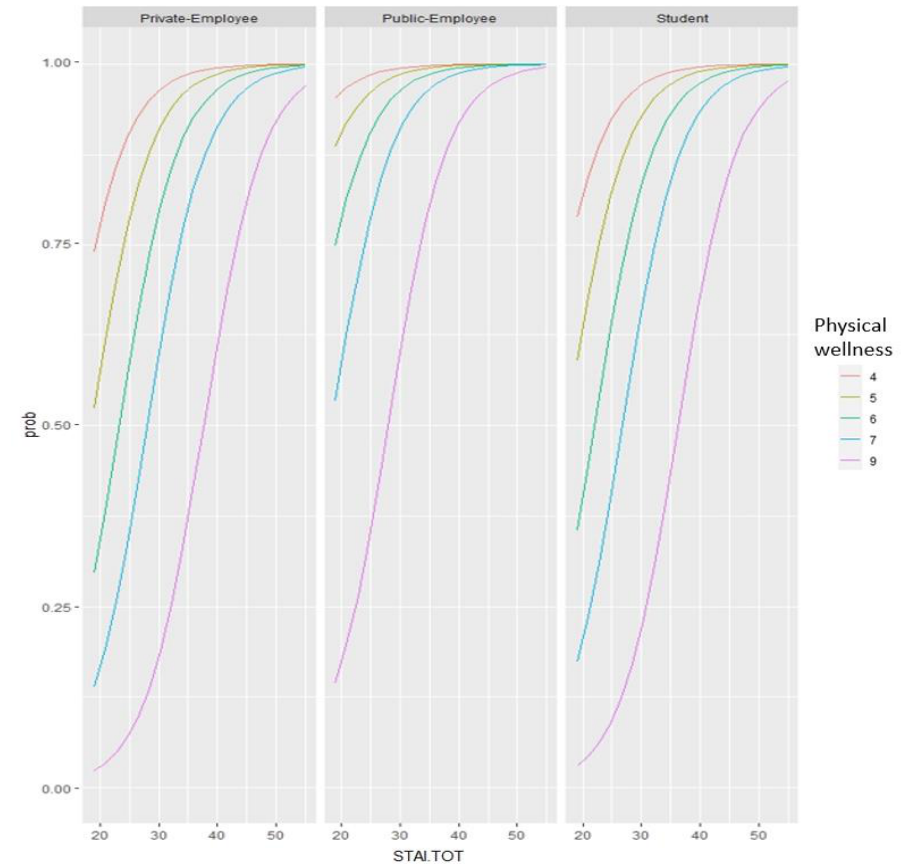
Figure 2. Graphic representation of the regression (only significant predictors) of sleep disorder in COVID-19 quarantine.